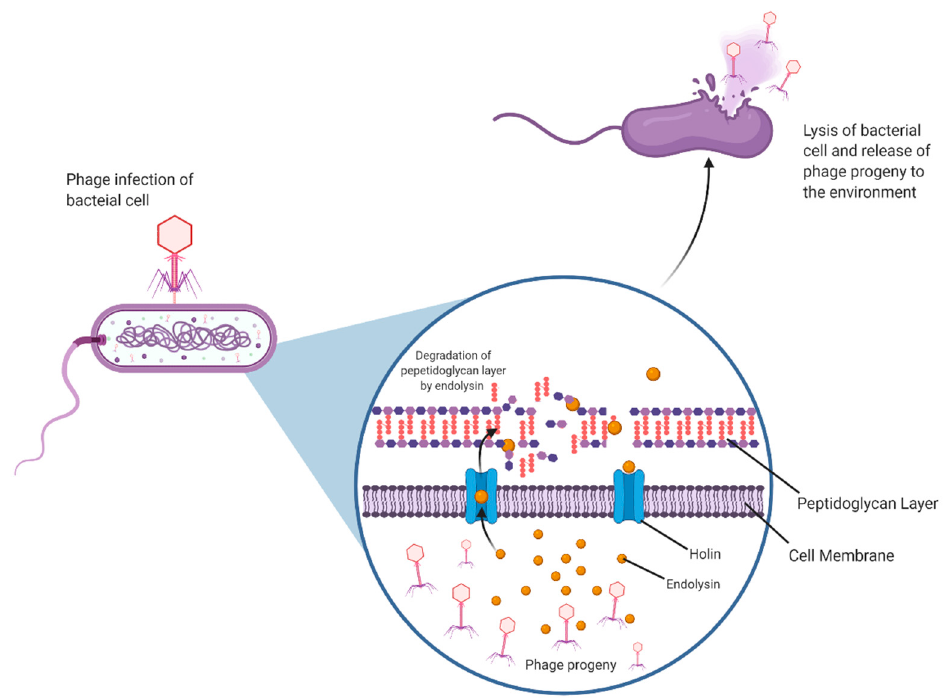
Figure 2. Phage Endolysin Mechanism. The process of a basic phage infection of a Gram-positive bacterial cell, and the role of endolysins and holins in infection.